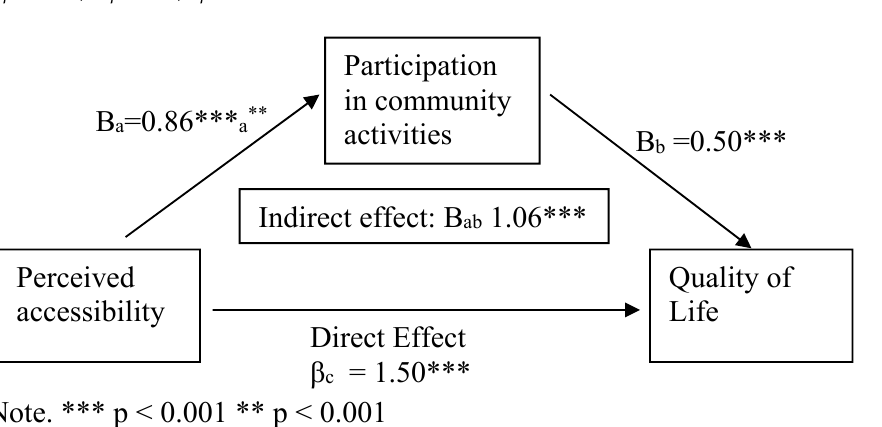
Figure 1. Regression analysis for mediation predicting quality of life. a. Independent Variable to Mediator; b. Direct effect of mediator on Dependent Variable; c. Direct effect of Independent Variable to Dependent Variable; ab. Indirect effect of Independent Variable on Dependent Variable through